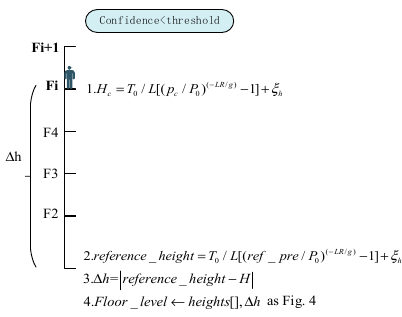
Figure 3. The floor prediction using the BPFP.